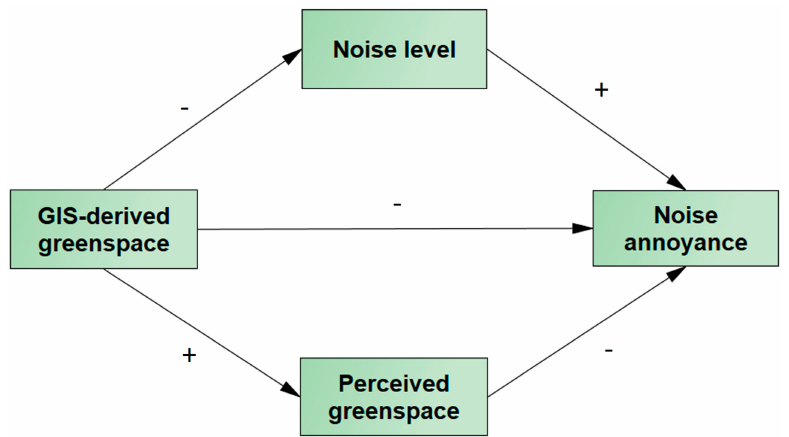
Figure 1. Conceptual diagram showing theoretically-indicated pathways linking Geographic Information System (GIS)-derived greenspace to noise annoyance. (Positive associations are marked with “+”, and negative associations, with “ −